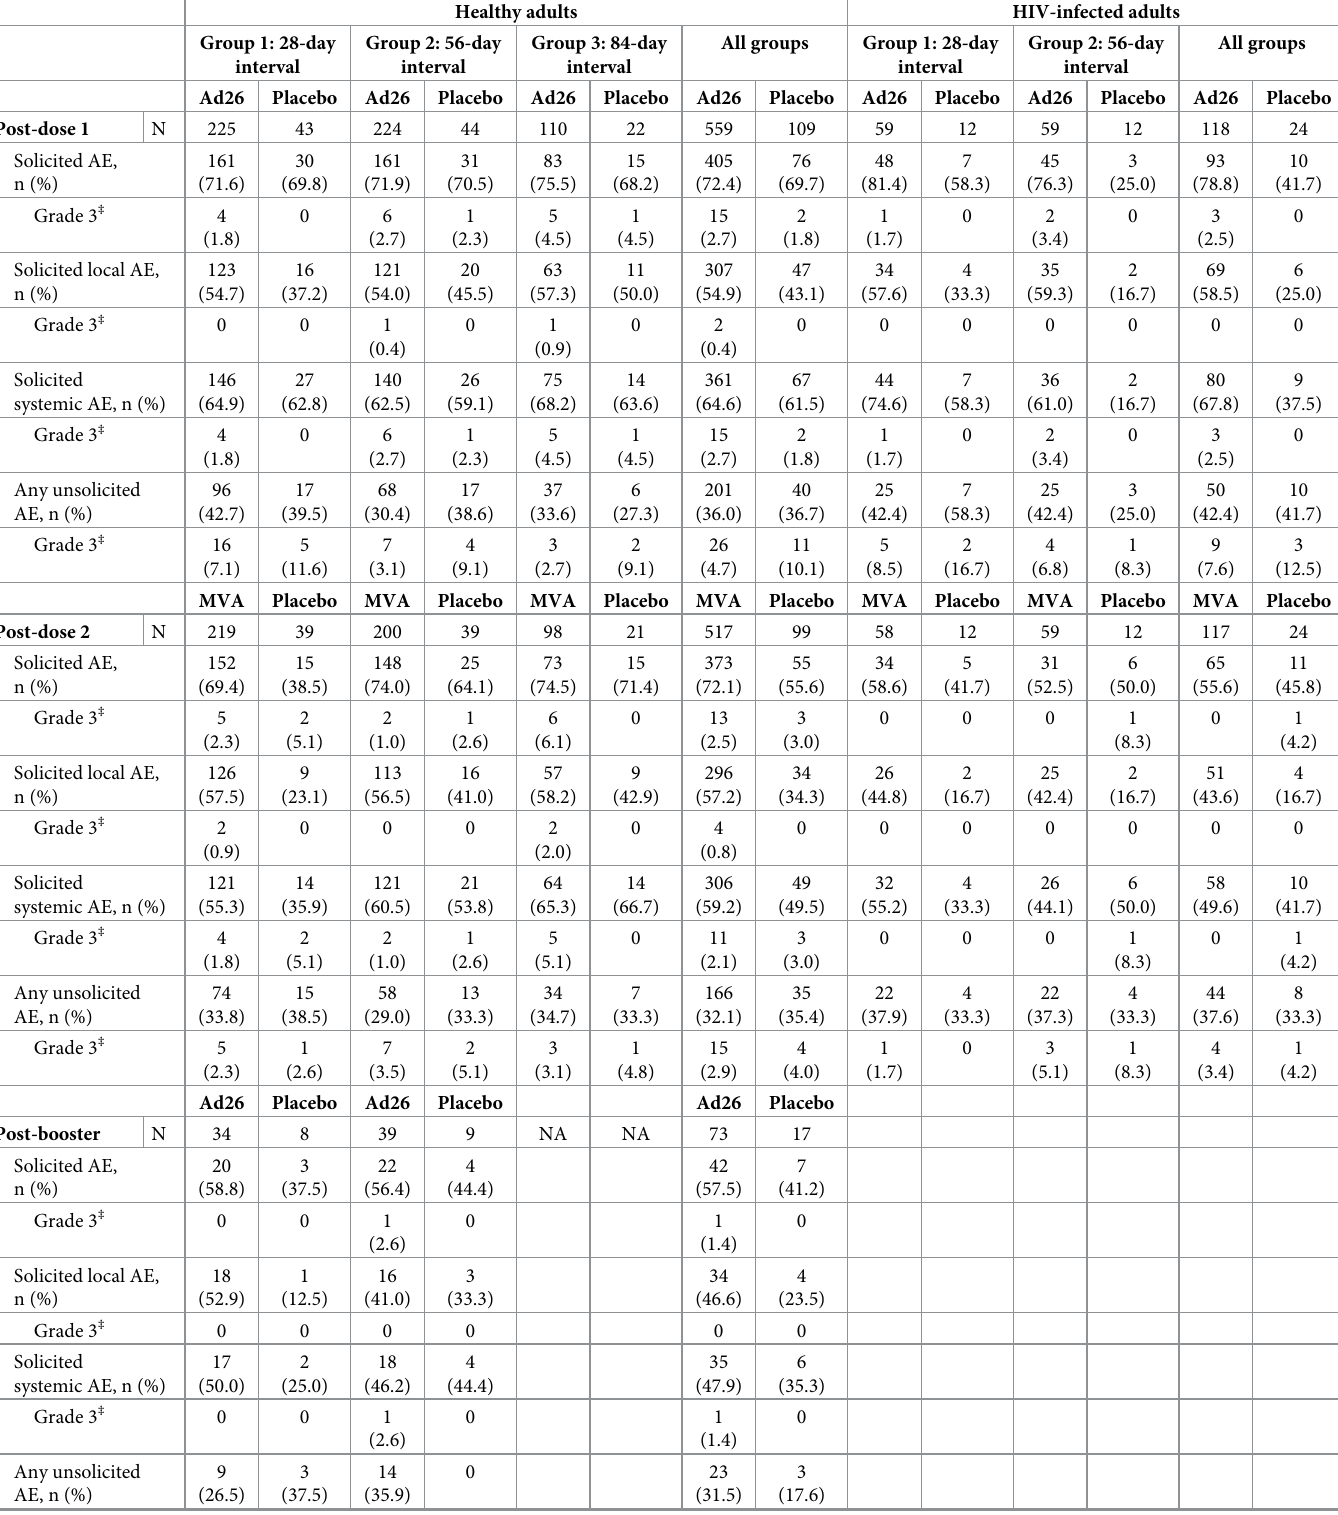
Table 2. Solicited and unsolicited AEs in the full analysis set after each vaccination dose, no. (%).